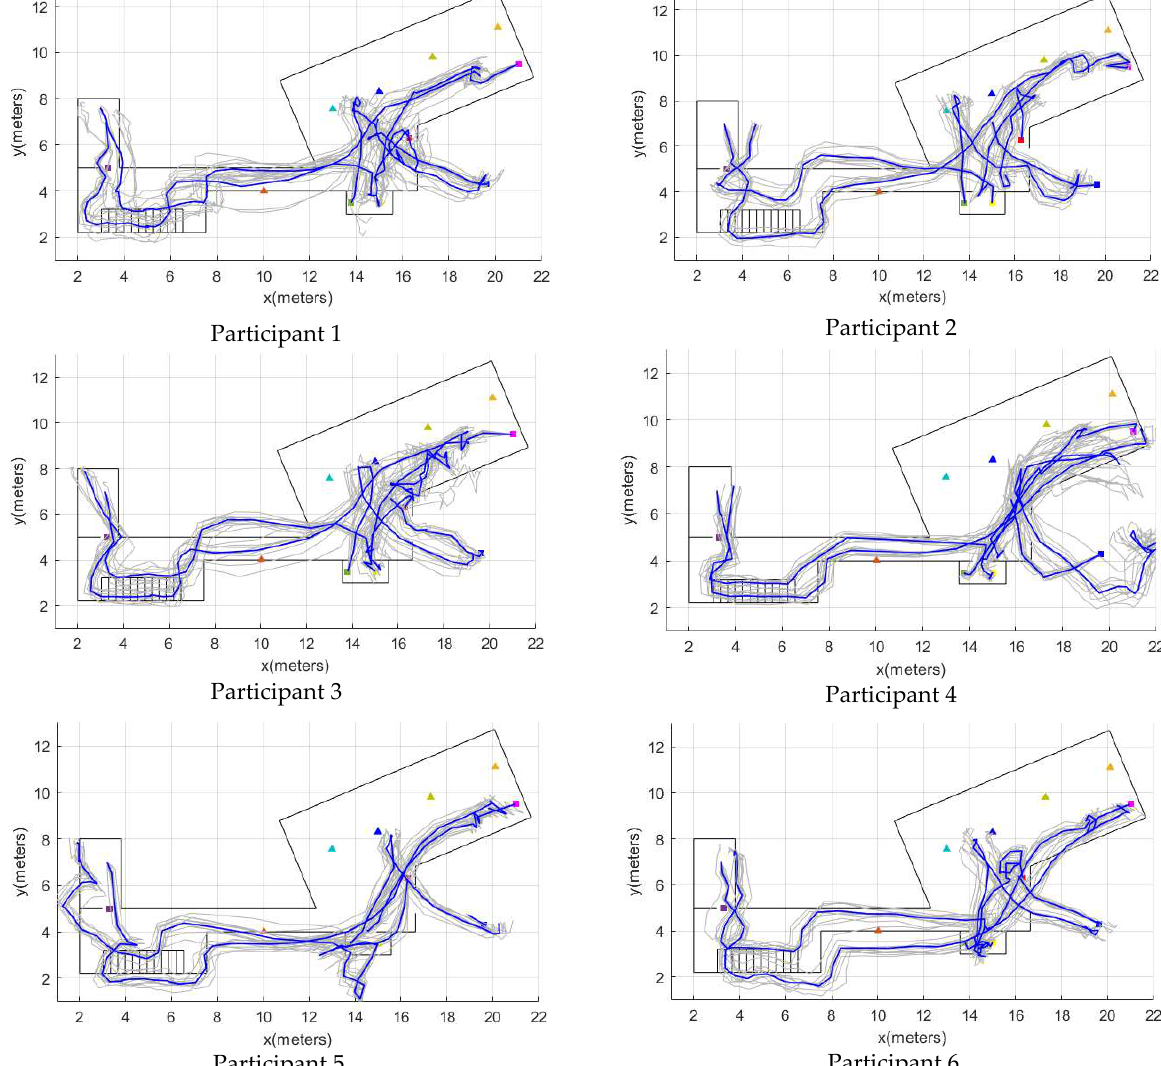
Figure A1. Indoor localization results (Older adults’ group, participants 1–6).